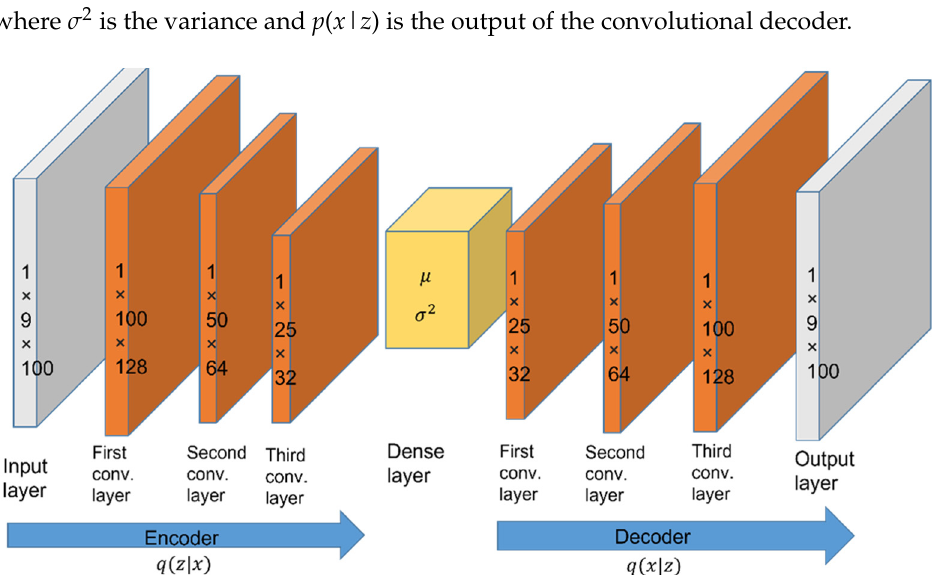
Figure 5. The proposed generative adversarial network. The two modules, a sequence of skeleton generator and an activities discriminator, are trained by using the G and D loss functions, respectively. The GAN training is a